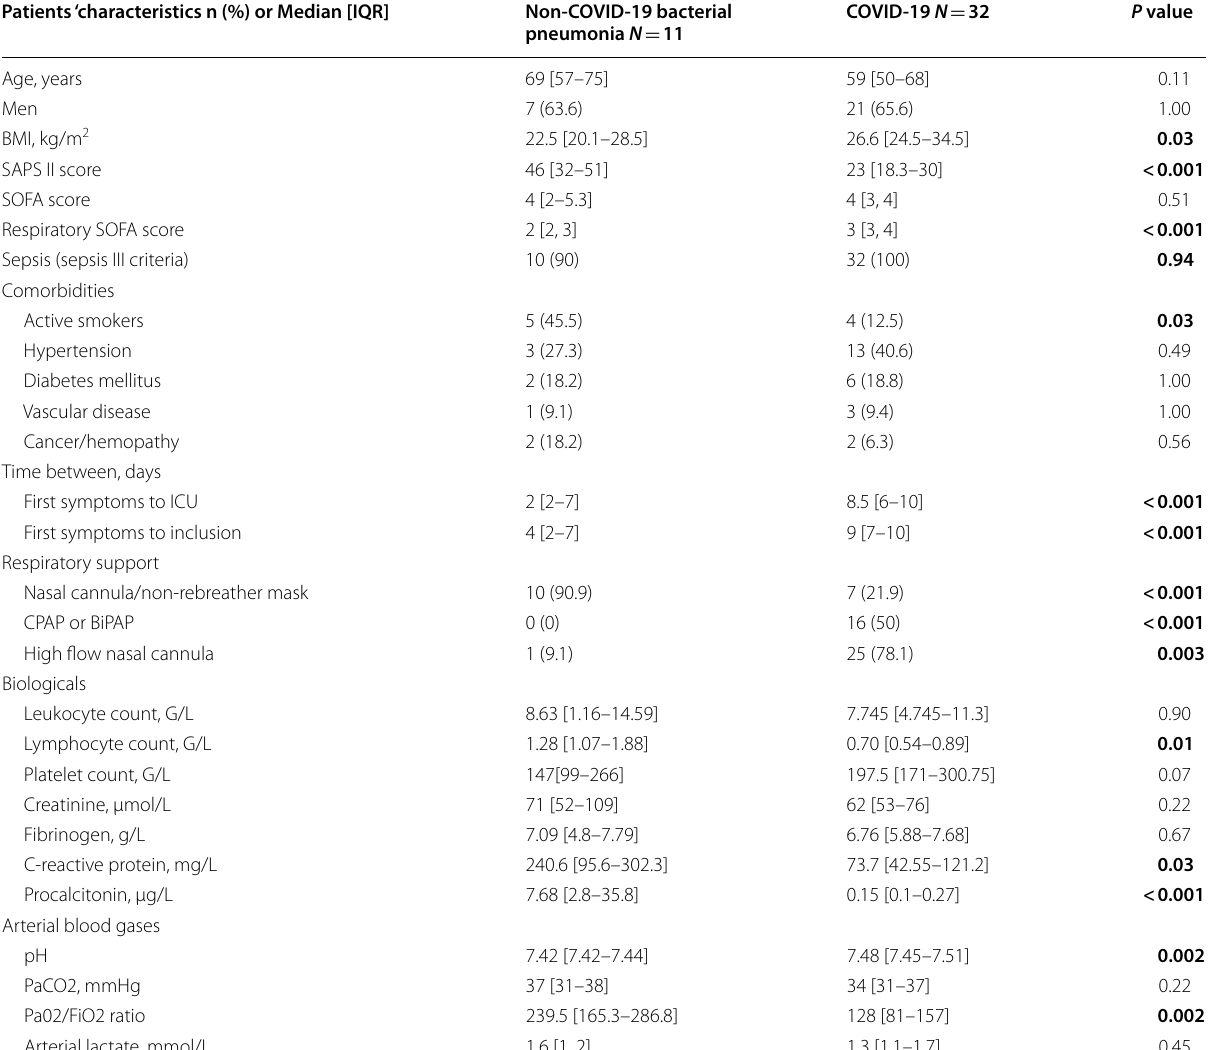
Patients ‘characteristics n (%) or Median